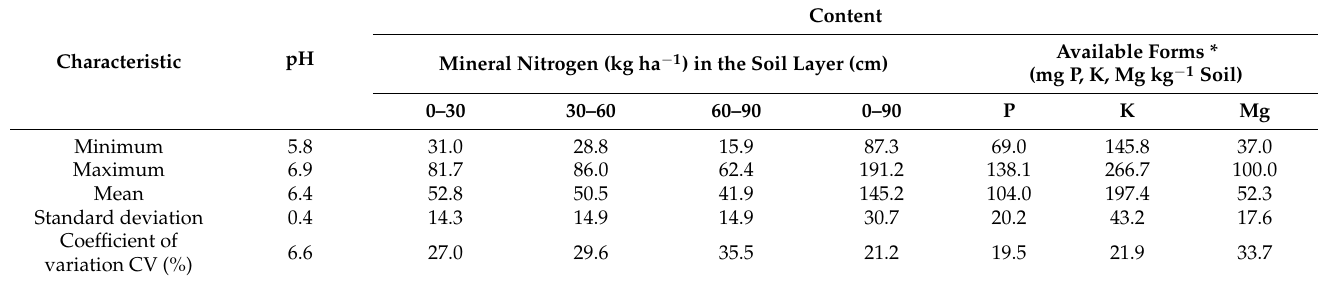
Table 2. Description of soil agrochemical